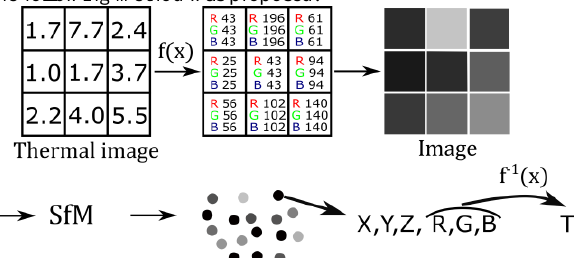
Figure 4. Workflow of photogrammetric processing of thermal